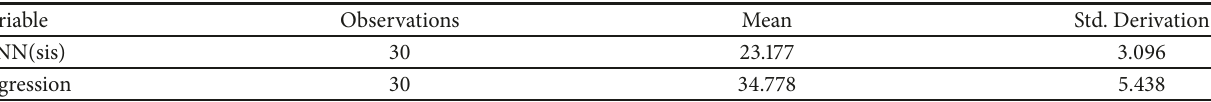
Table 10: Descriptive statistics Module 2 (diastolic).